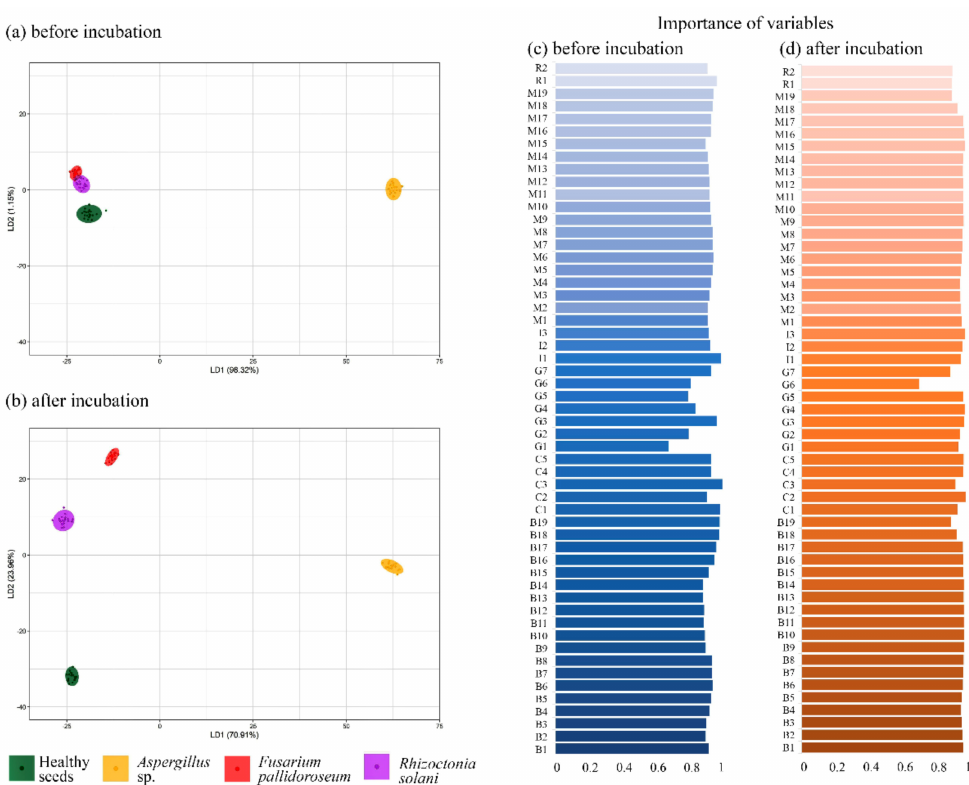
Figure 4. Linear discriminant analysis (LDA) score plot based on reflectance, color and texture features of cowpea seeds at 19 wavelengths (365 to 970 nm) for class membership of inoculated seed ( a ), and incubated seed ( b ) with Healthy seeds, Fusarium pallidoroseum, Rhizoctonia solani and Aspergillus sp. Importance of variables in the models before inoculation ( c ), and after incubation ( d ). Attributes: Color and texture features – (R2): RegionMSIThresh; (R1):